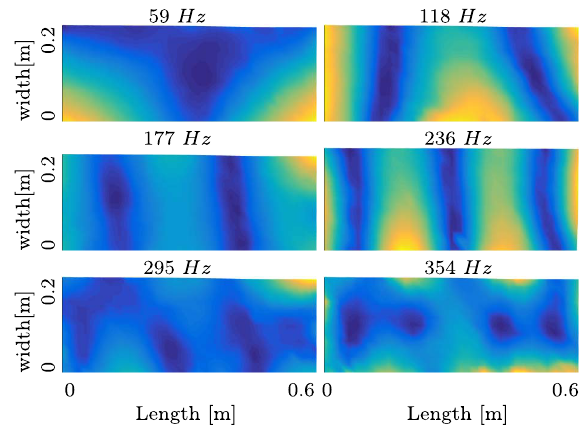
Figure 11. Operational de fl ection shapes for pulsation frequen- cies of segment with straight tube in the middle (Fig.